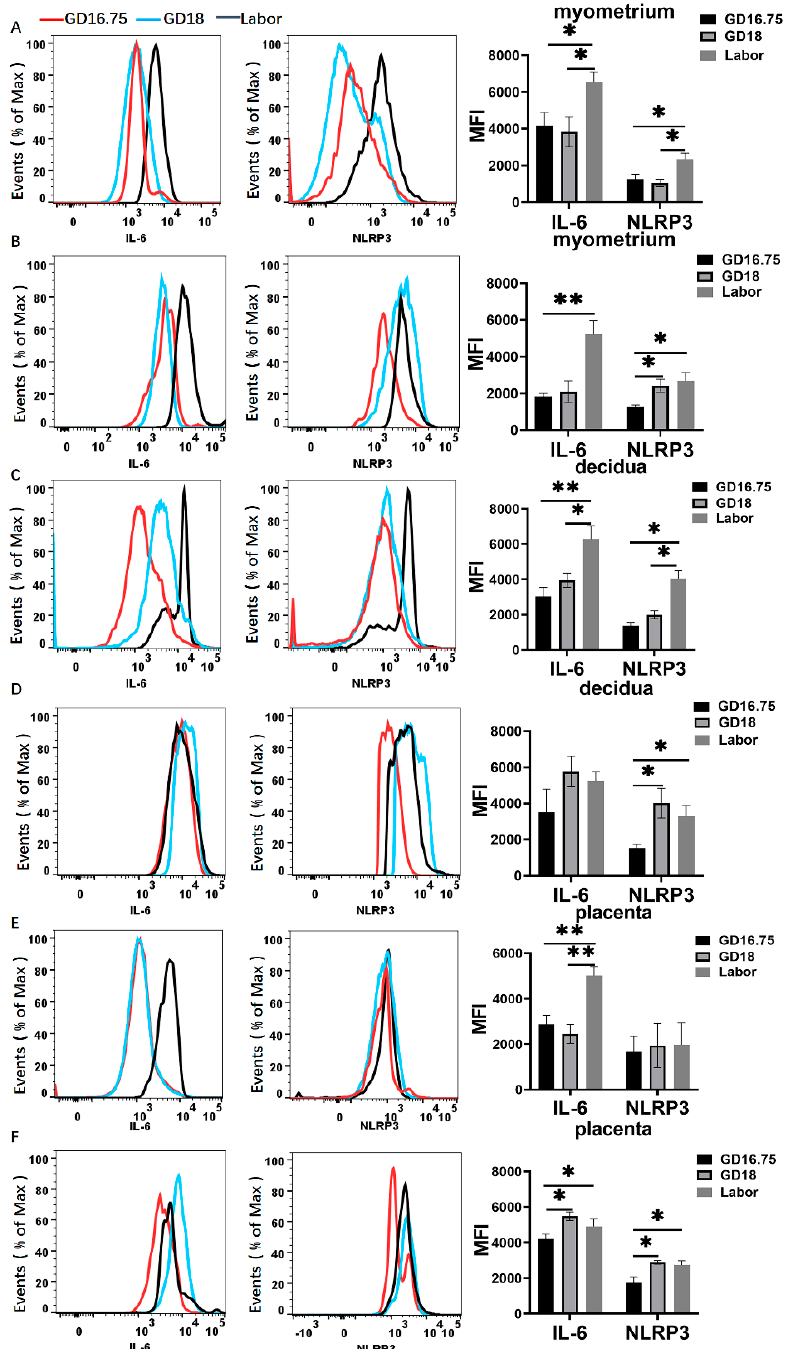
Figure 4. Characteristics in IL-6 and NLRP3 expression in gestational tissues at late gestation and labor. The pregnant mice were sacrificed at GD16.75, GD18, and labor. Myometrium, decidua, and placenta were obtained for determination of the expressions of IL-6 and NLRP3 by flow cytometry analysis. ( A , B ) Flow cytometry of IL-6 and NLRP3 expression among total leukocytes ( A ) or macrophages ( B ) in myometrium. ( C , D ) Flow cytometry of IL-6 and NLRP3 expression among total leukocytes ( C ) or macrophages ( D ) in decidua. ( E , F ) Flow cytometry of IL-6 and NLRP3 expression among total leukocytes ( E ) or macrophages ( F ) in placenta. Representative flow cytometry evaluating IL-6 and NLRP3 expressions (the left panel) and statistics calculated by the mean fluorescence intensity (MFI) of IL-6 and NLRP3 (the right panel) from total leukocytes (CD45 + ) or macrophages (CD11b + F4/80 + ). Data are expressed as mean ± SEM. n = 5 in each group. * p < 0.05, ** p <